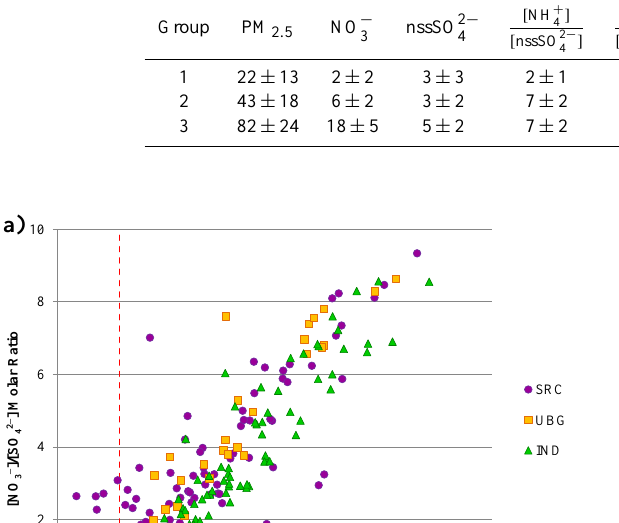
Table 3. Mean and standard deviation for PM 2 . 5 (µgm − 3 ), NO −